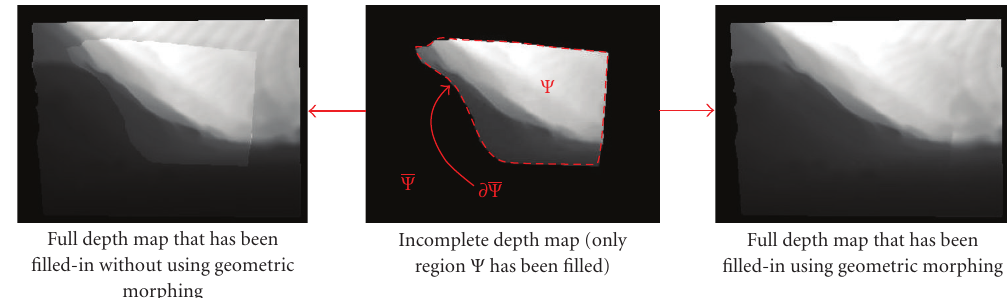
Figure 6: In the middle, we show an incomplete destination depth map (cid:16) Z dst , whose region Ψ has been filled-in by using the optical flow from Figure 5 and applying (6). On the left, we show the full destination depth map that has been produced by extending (cid:16) Z dst to region Ψ = R k − Ψ without using geometric morphing. Notice the discontinuities existing along the boundary ∂ Ψ . On the right, we show the full destination depth map that has been produced when geometric morphing has been enabled. As can be seen, no discontinuities exist along the boundary ∂ Ψ in this case.